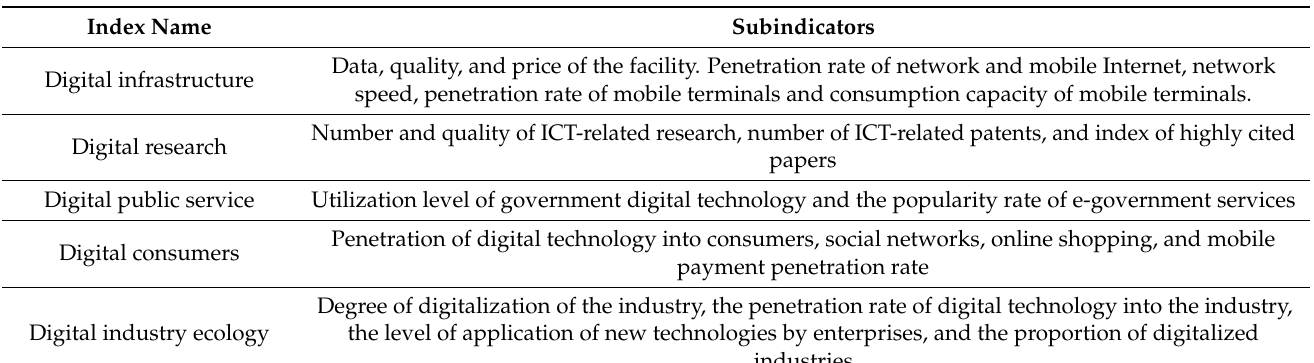
Table 2. Five dimensions of digital economy published by Alibaba and KPMG.